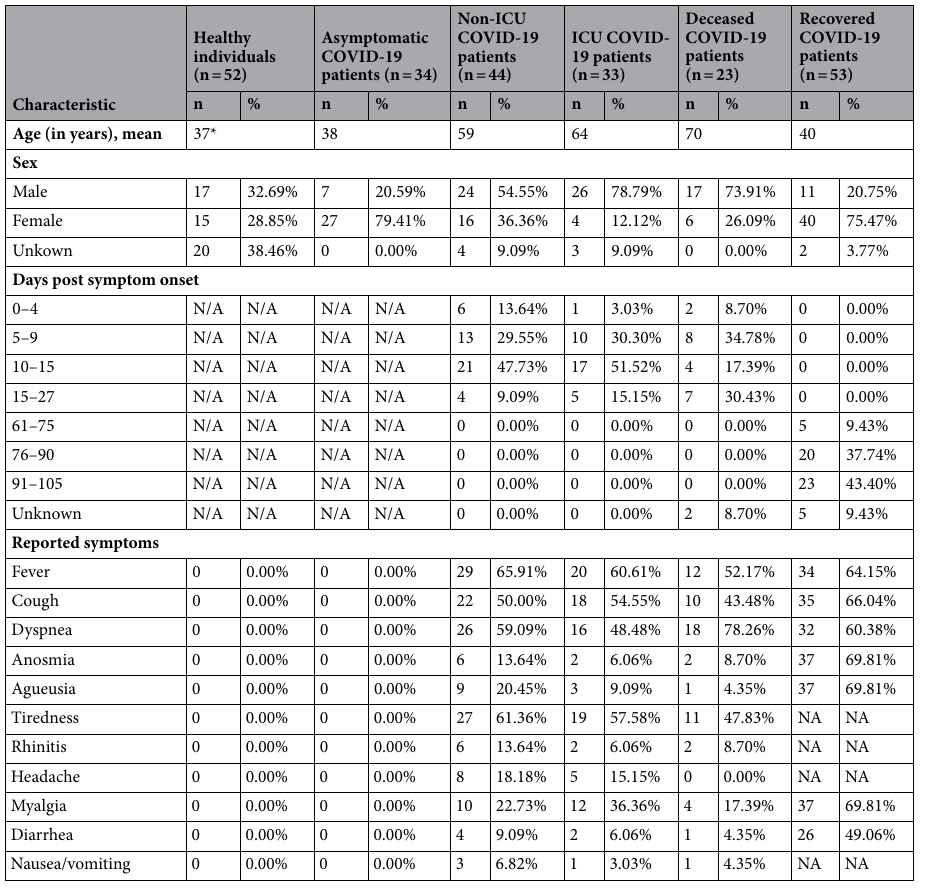
Table 1. Clinical characteristics of the six cohorts. *Data available for 32 cases. NA not available. N/A not